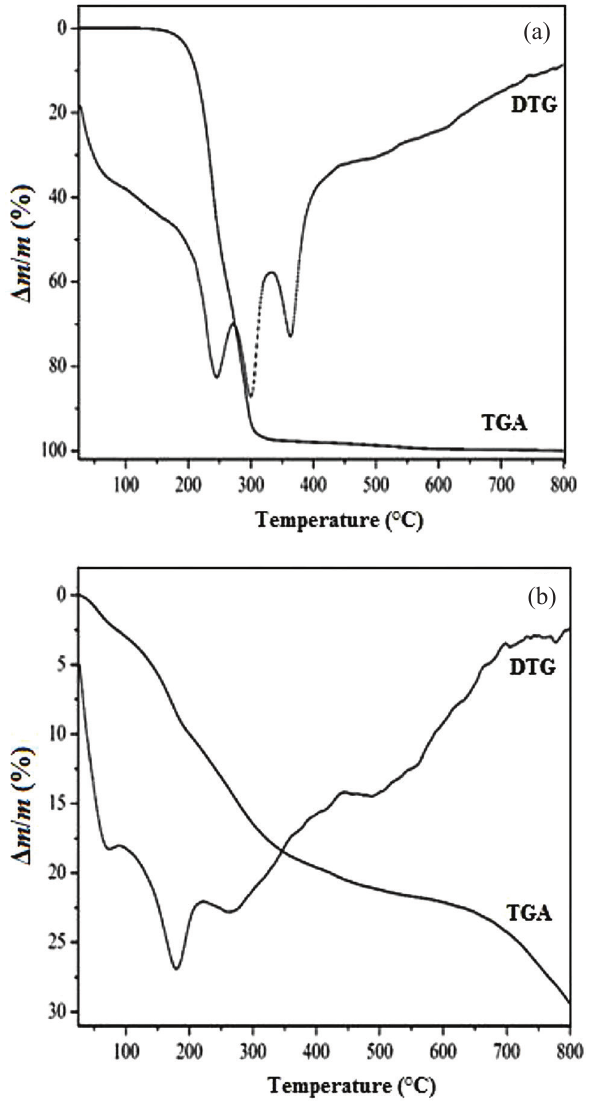
Fig. 10 – Analysis TGA/DTG of free drug CA (a), and after its retention by CLDH (b)